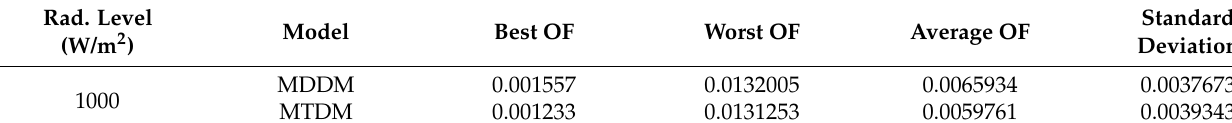
Table 7. Statistical analysis for MDDM and MTDM by EHO algorithms for 57 mm diameter commercial (R.T.C. France) silicon solar cell at 1000 W/m 2 and 306 K.